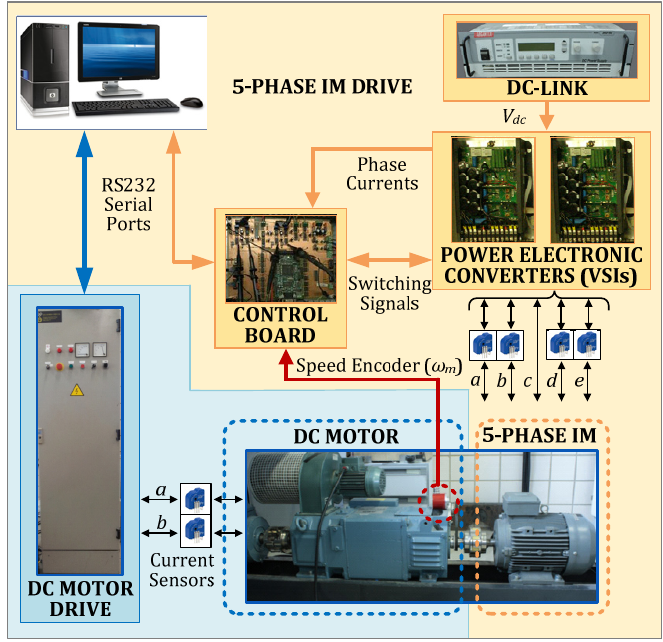
Figure 3. Scheme of the experimental test bench.